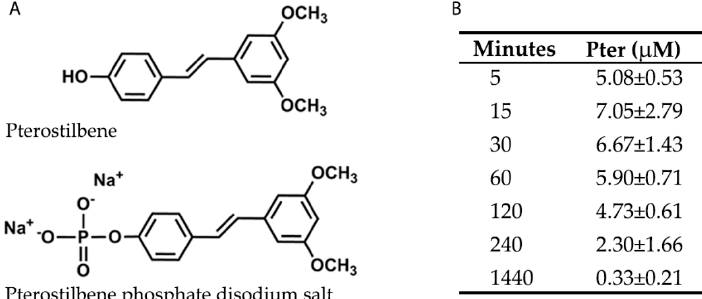
Figure 1. Chemical structures and plasma levels of Pter after administering Pter phosphate disodium salt. The pharmaceutical form of disodium salt of Pter phosphate was used to facilitate its daily subcutaneous administration in vivo. ( A ) Chemical structures of Pter and Pter phosphate disodium salt. ( B ) A subcutaneous injection of Pter phosphate disodium salt (Pter 50 mg/kg) was administered dissolved in water (25 mg/mL). Blood was collected at different times and Pter was quantified in plasma by the UPLC-MS / MS analysis. The results are the means ± S.D. of four di ff erent rabbits.